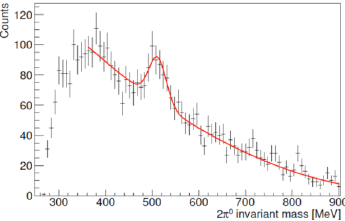
Figure 9. π 0 π 0 invariant mass distribution obtained from a deuteron target with cuts on the topology of the reaction Σ 0 . The K 0 γ n → K 0 exhibits itself as a clear enhancement. s s The proton of the decay Σ 0 → p π 0 was required in the forward spectrometer. With the cuts applied no K 0 signal is visible with proton